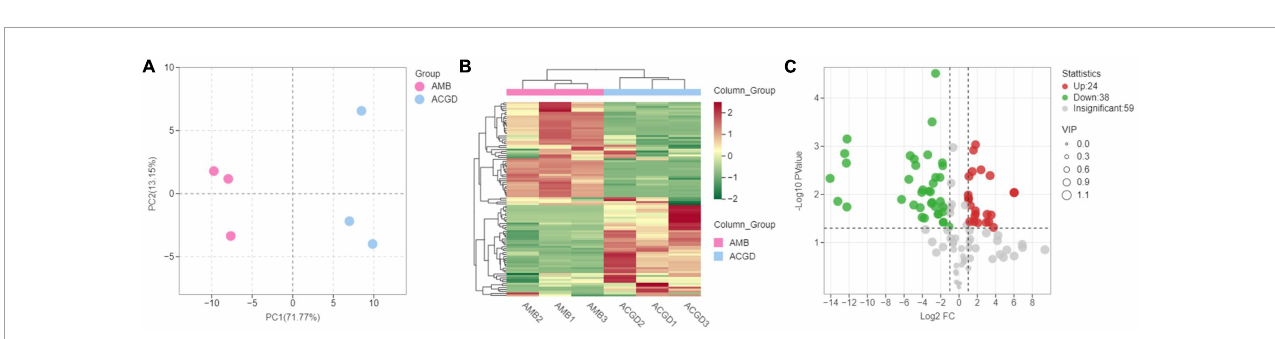
FIGURE7 The principal component analysis (PCA) between Allium macrostemon Bge. (AMB) and Allium chinense G. Don (ACGD) samples by HS-SPME-GC/MS (A) ; volatile organic compounds (VOCs) accumulation pattern of AMB and ACGD (B) ; volcano plots of differentially VOCs between AMB and ACGD (C) ; the green dots represent down-accumulated compounds, and the red dots represent up-accumulated volatiles between these two